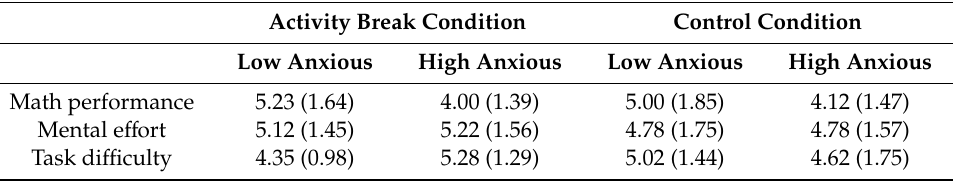
Table 2. Means (SD) of math performance, mental e ff ort, and task di ffi culty as a function of condition and children’s anxiety